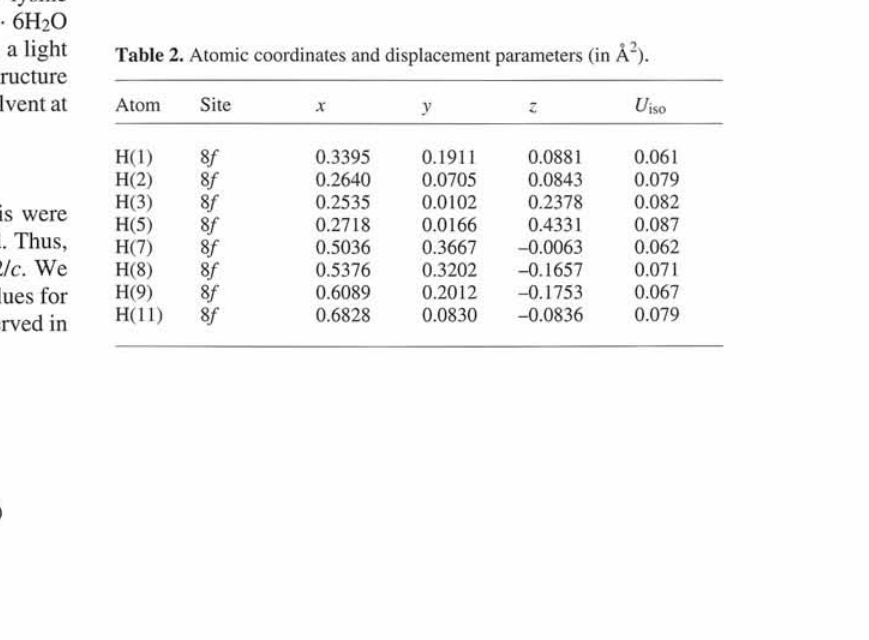
Table 2. Atomic coordinates and displacement parameters (in